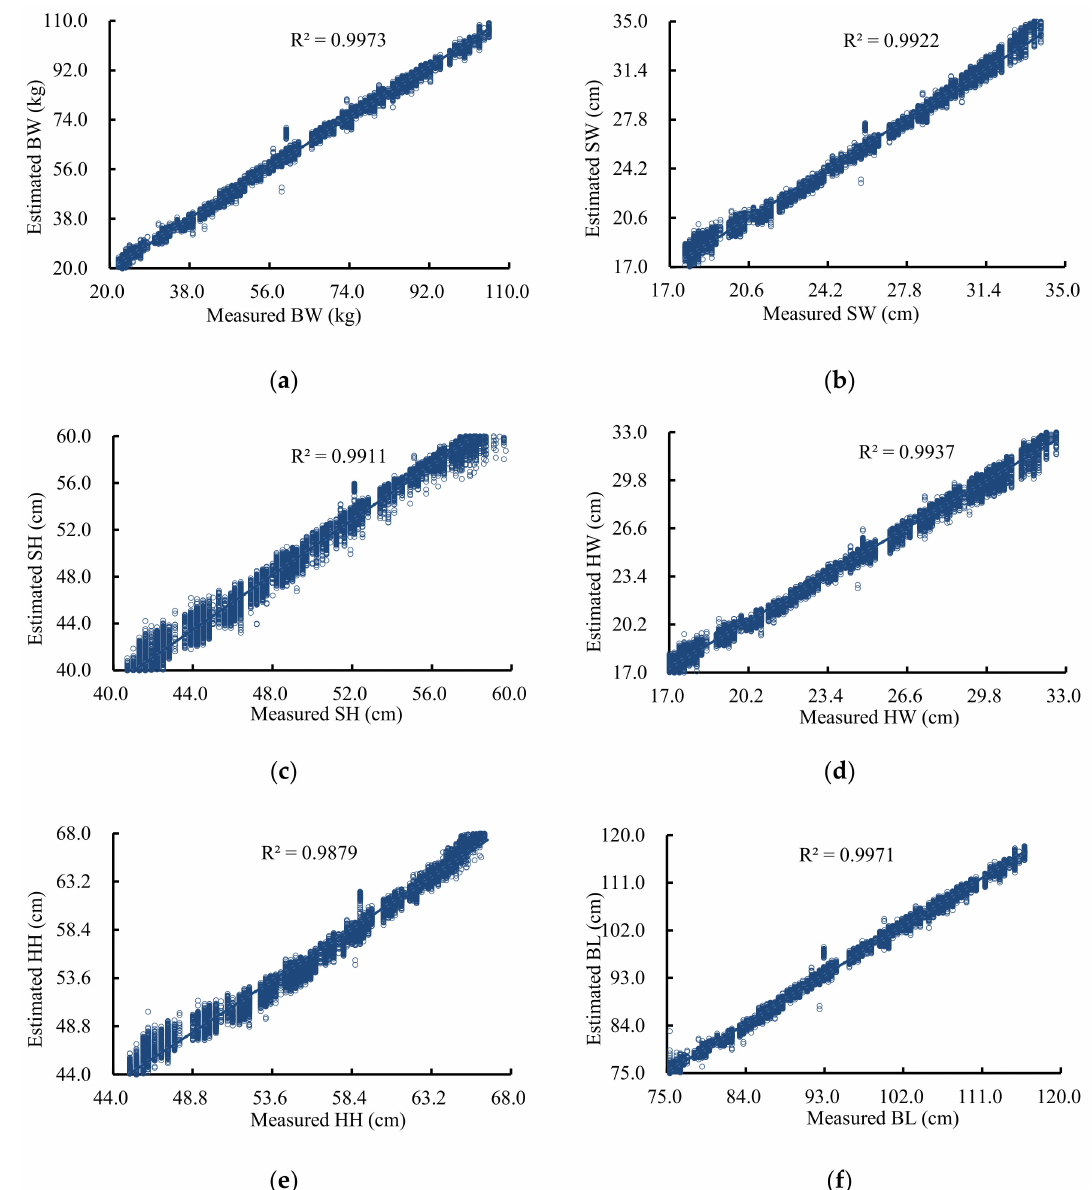
Figure 8. Comparison between measured and estimated BW ( a ), SW ( b ), SH ( c ), HW ( d ), HH € and BL ( f